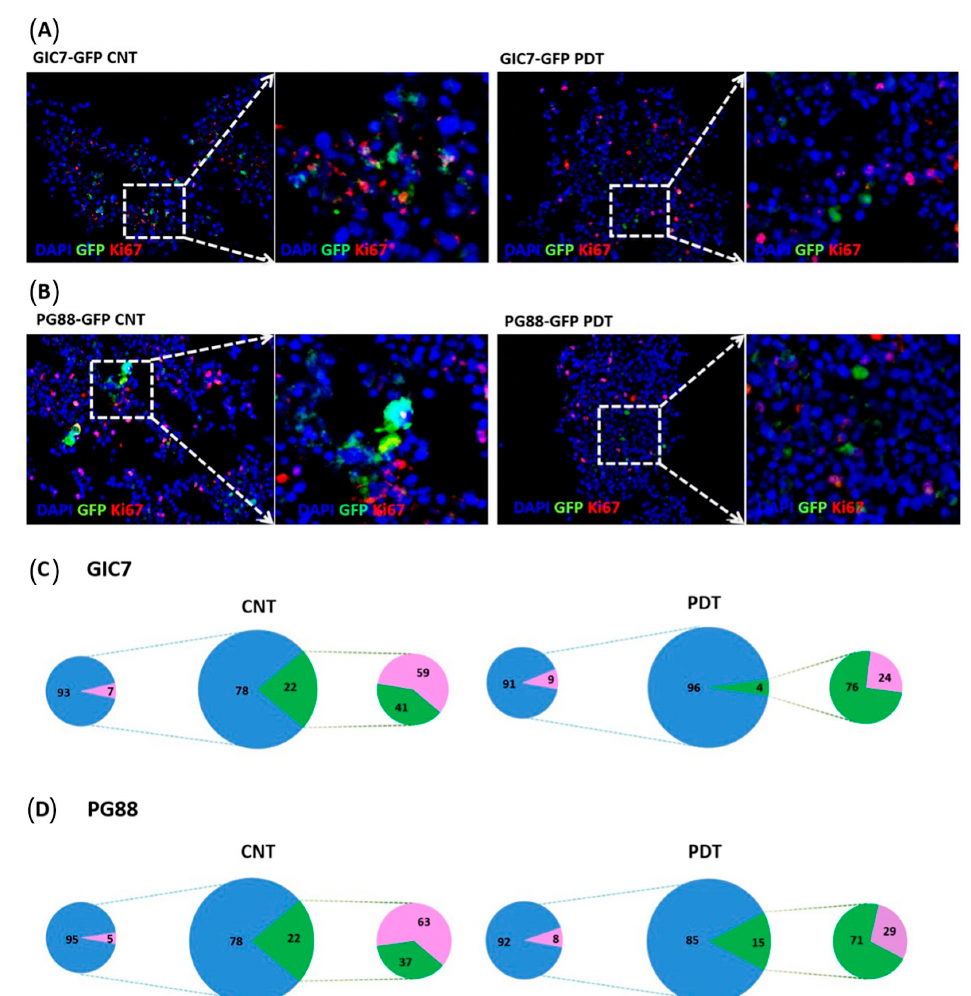
Figure 10. Proliferation study of GFP-GICs and organoids co-culture by Ki67. GIC7 and PG88- organoid co-cultures treated or not with PDT based on 5-ALA uptake after 5-ALA 50 µ g/mL treatment or medium alone. Fixed tissues were sliced at 12 µ m to perform IF analysis with anti-Ki67 antibody (pink staining), scale bars 20 µ m. Green fluorescent GICs infiltrated the organoid (green color), GIC7 ( A ) and PG88 ( B ) 5-ALA controls (left panels) show less positive pink nuclei (amplified in the small square at right) than PDT treated co-cultures (besides and amplified at right panels). Blue DAPI-stained nuclei were used to counterstain cells. Semiquantitative analysis of Ki67 positive cells was performed from: GIC7-5-ALA CNT, 7 fields from 1 sample; GIC7-PDT treated, 13 fields from 2 samples; PG88-5-ALA CNT, 8 fields from 1 sample and PG88-PDT treated, 11 fields from 2 samples. Results as a percentage average of positive cells are represented in ( C, D ) pictures: green color (GFP-GICs cells), blue DAPI-stained nuclei, and pink Ki67 positive cells; comparing controls (left part) and PDT samples (right part). Significant differences between GIC7-5-ALA CNT and GIC7-PDT-treatment ( p = 0.0001) and between PG88-5-ALA CNT and PG88-PDT-treatment ( p < 0.01) were found.